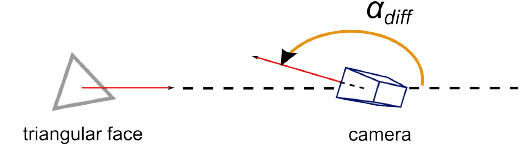
Figure 2. Geometry of the angle between a face’s normal vector and the looking vector of the